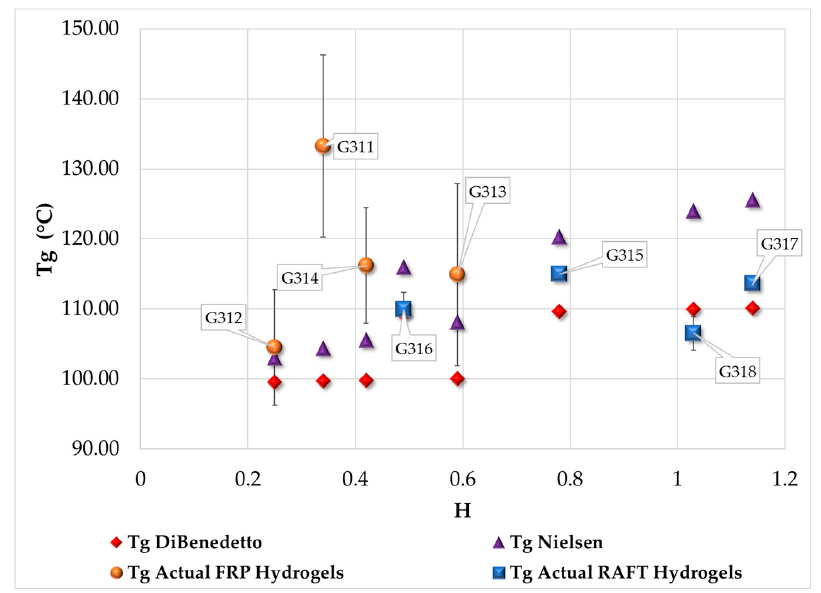
Figure 10. Relationship between Tg measured by MDSC and H and comparison with Tg estimates from the Nielsen and DiBenedetto equations.